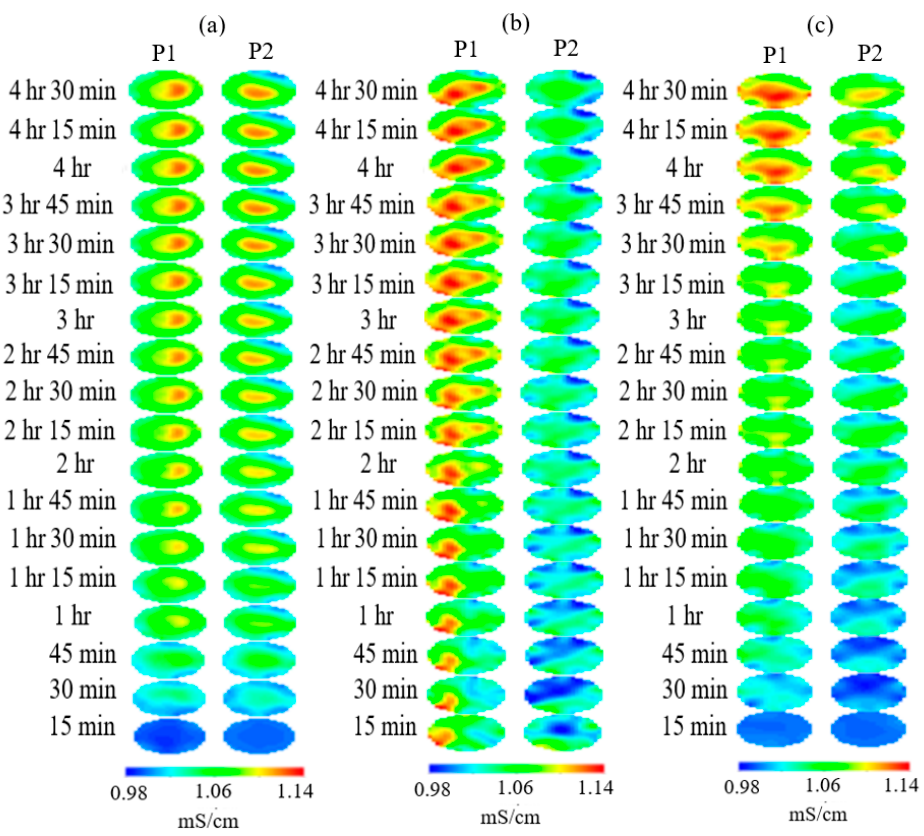
Figure 5. The dual plane tomograms for the flooding runs no. 1 involving ( a ) no NF ( b ) 0.5 wt% SiO 2 and ( c ) 1 wt% SiO 2 revealing the effect of 10 nanofluid pulsations after 1 h and 15 min of water-flooding.